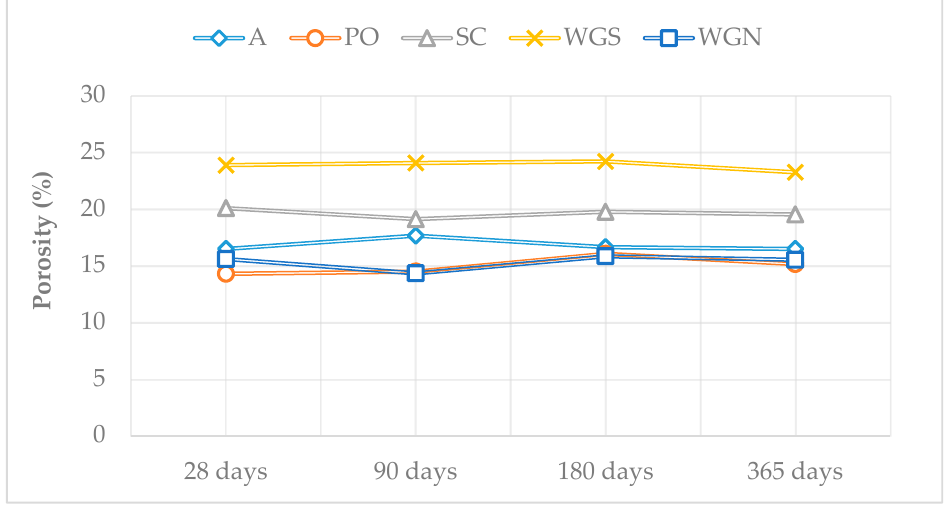
Figure 4. The porosity of the mortars at all ages tested.